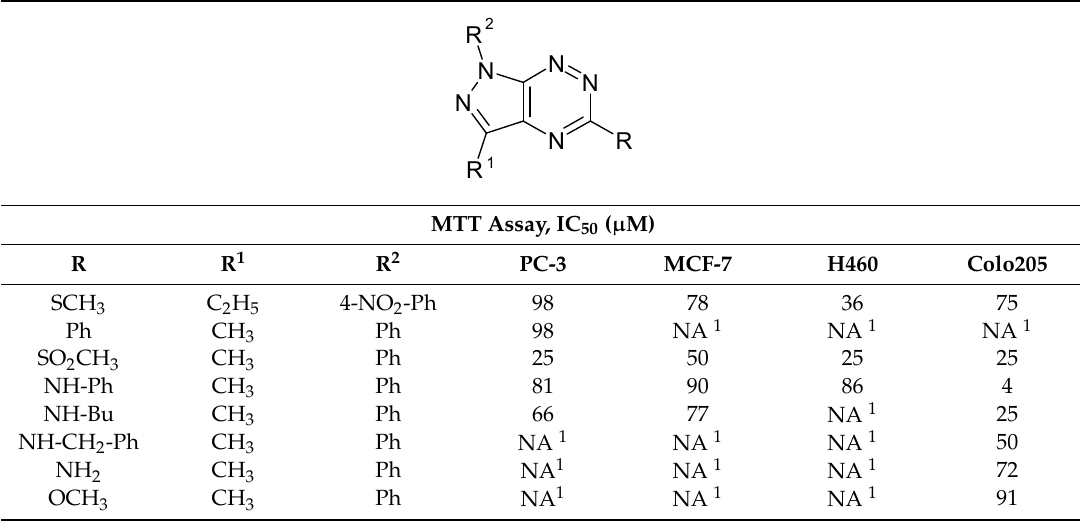
Table 2. Cytotoxicity of simple pyrazolo[4,3- e ][1,2,4]triazines.